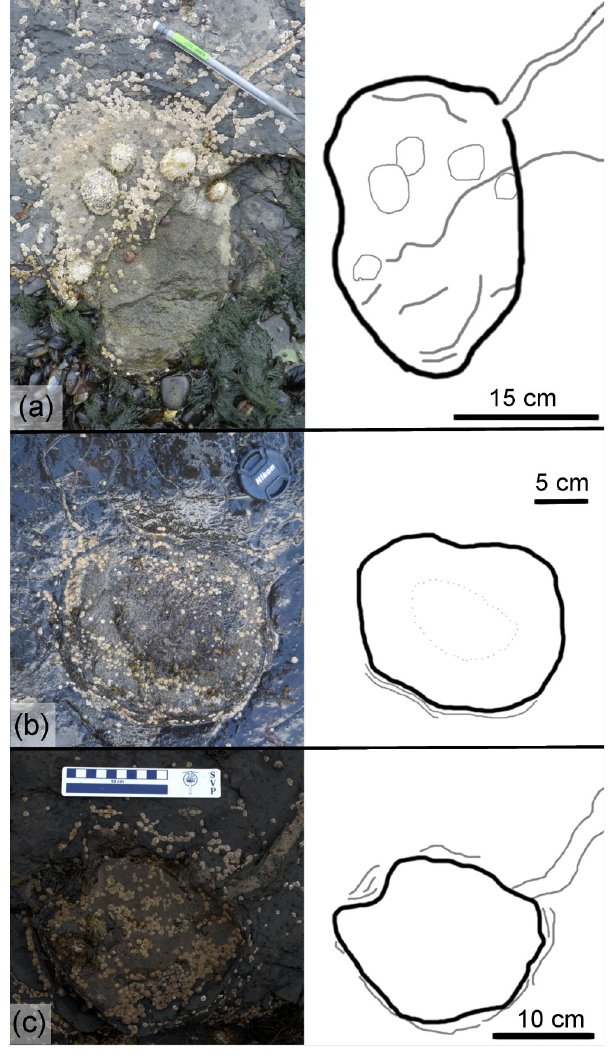
Fig 8. Isolated tracks with similar morphology to BP1_Twy_01 at BP1. Several isolated tracks at BP1 show similar morphologies to those of quadrupedal trackway BP1_Twy_01 from the elongate, subtriangular shape of BP1_03 (a) to the sub-circular presentations of BP1_05 (b) and BP1_14